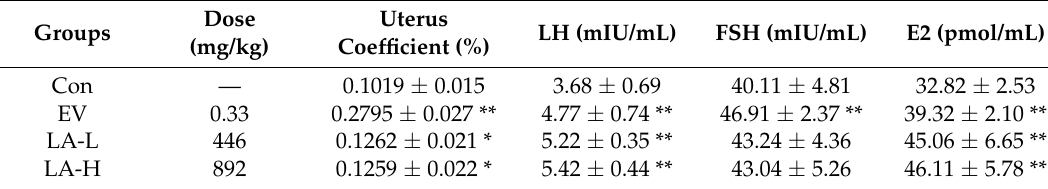
Table 1. Effect of LA on immature female Swiss mice ( x ± SD, n = 8).